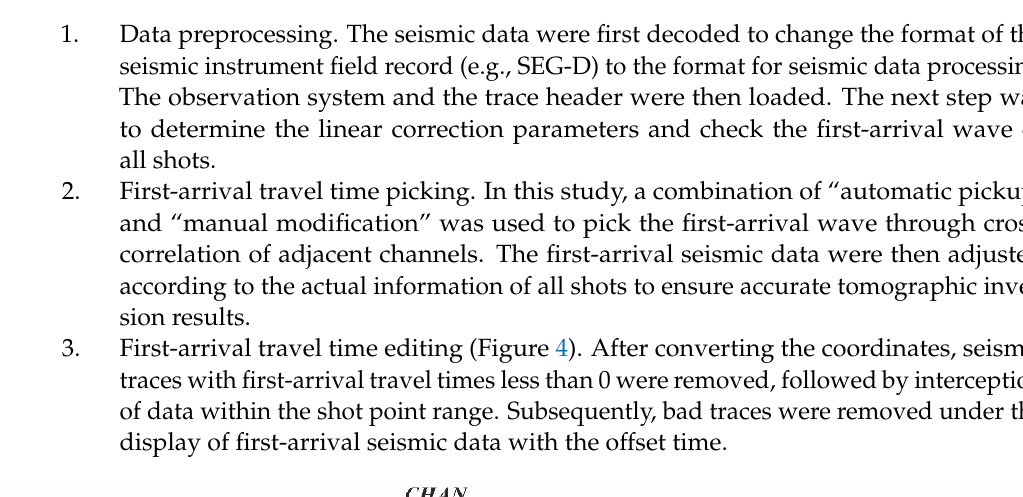
Figure 3. Flow chart of tomographic inversion processing.